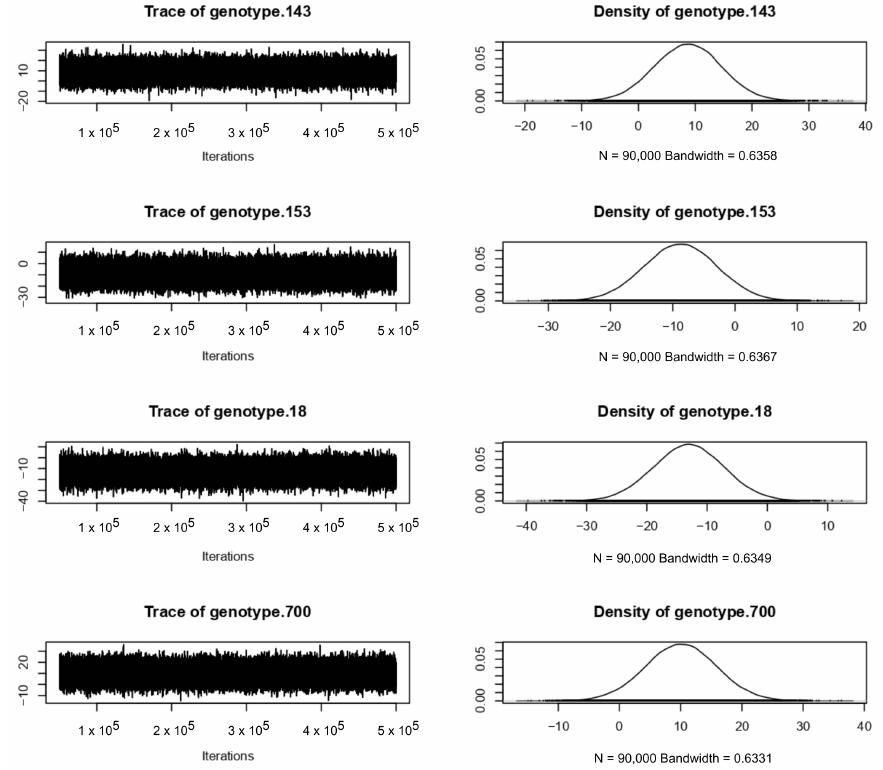
Figure A5. Time series of the chains and density curves of the effect of genotypes 143, 153, 18, and 700.